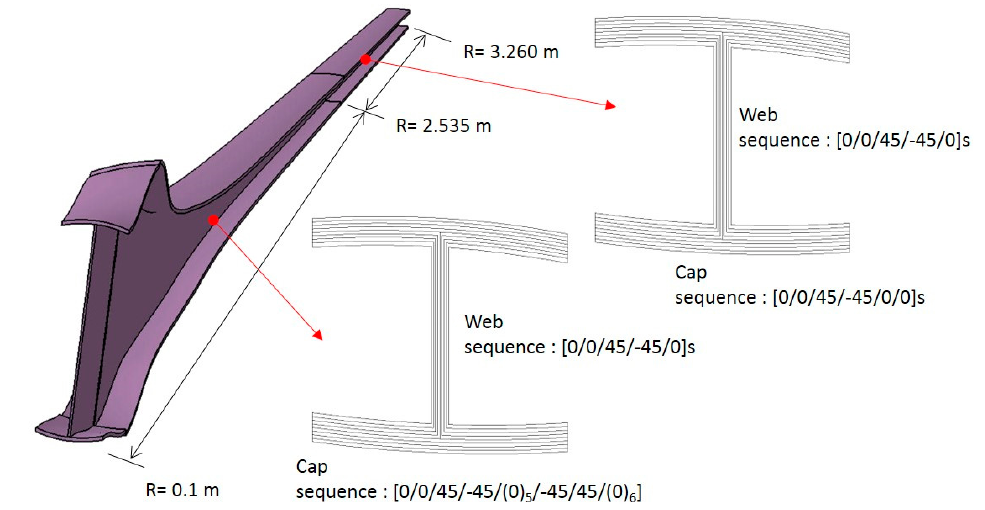
Figure 7. Main spar cross-section and stacking sequence.